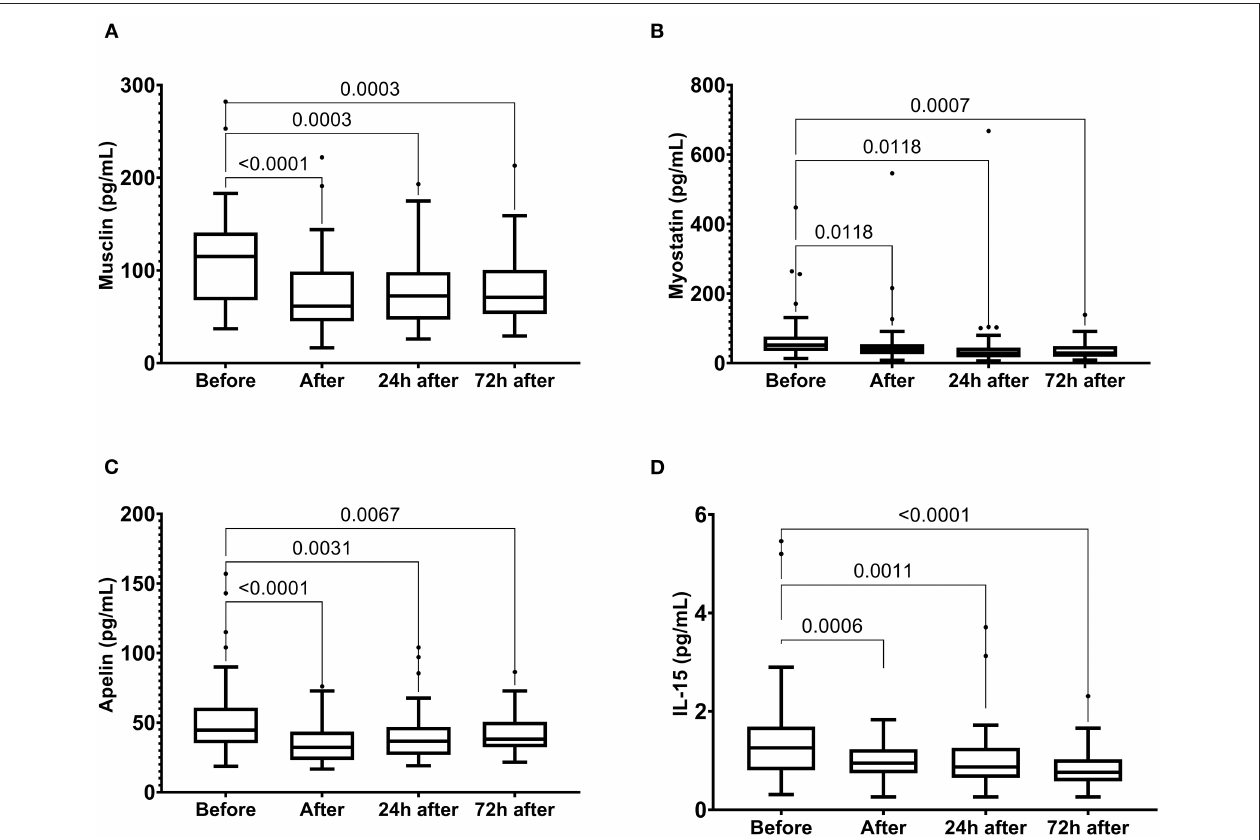
FIGURE 6 | The plasma levels of musclin (A) , myostatin (B) , apelin (C) and IL-15 (D) immediately after, 24h after, and 72h after the race. The values are presented as minimum, maximum, median, and outliers of 48 runners (Box plot, Tukey).